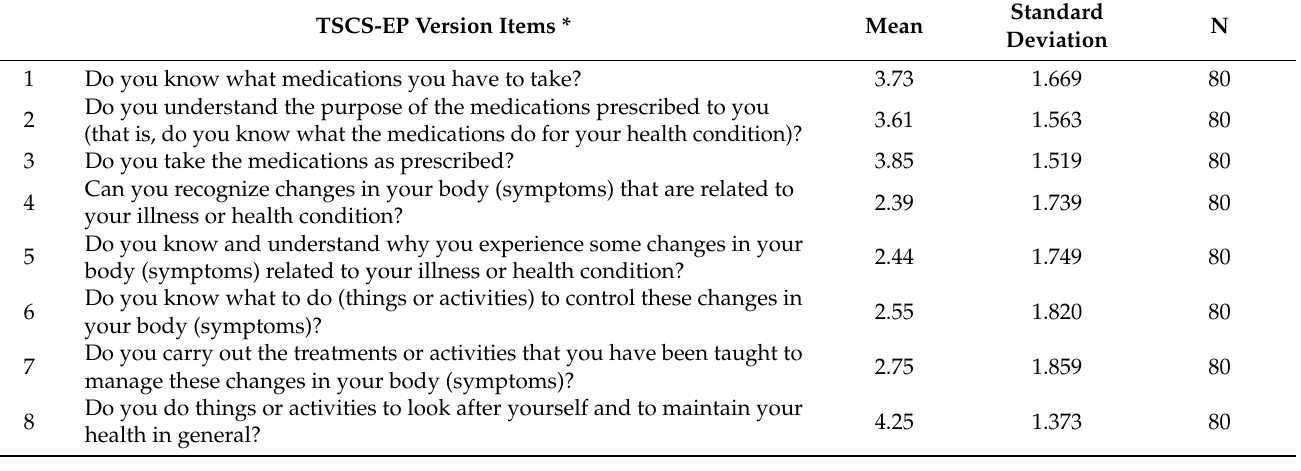
Table 1. Descriptive statistics for the Therapeutic Self-Care Scale European Portuguese version